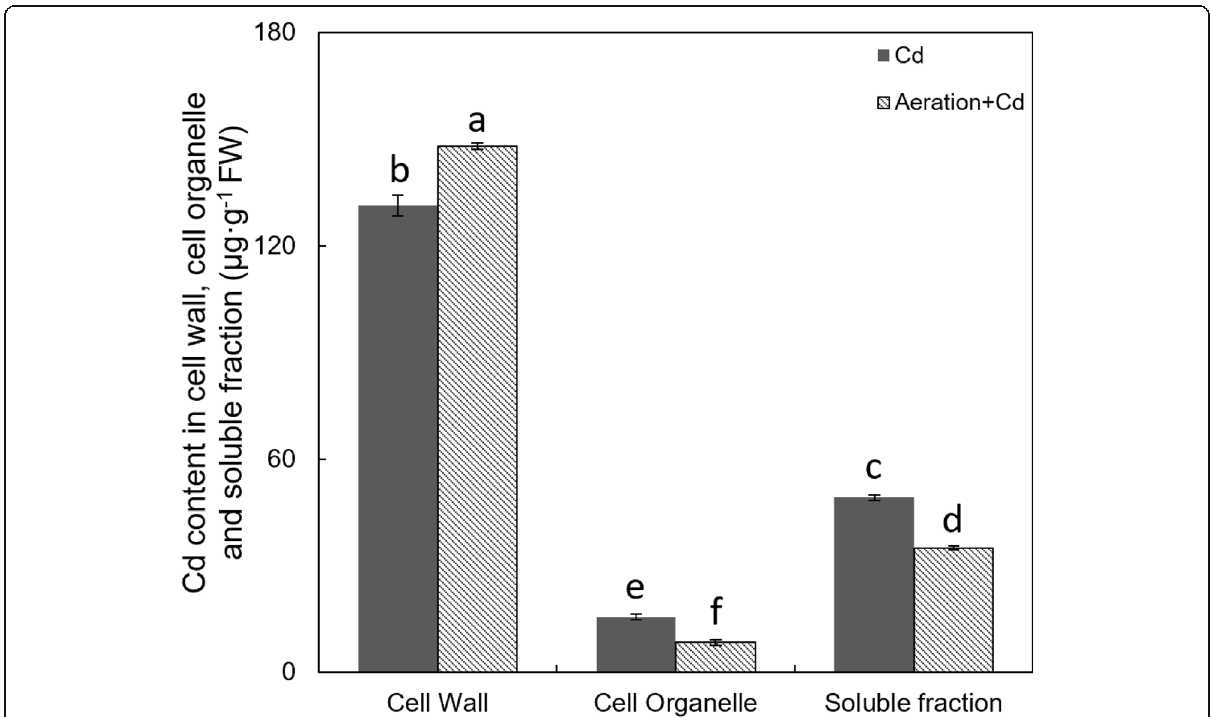
Fig. 6 Effects of aeration or/and 50 μ M CdCl 2 treatments on the location of Cd in rice root cells. Figure indicates Cd content in cell wall, cell organelle and soluble fraction. The 3-week-old rice seedlings under hydroponic culture were aerated with air pump (30 min per hour) in the absence or presence of 50 μ M CdCl 2 for 14 d. The values are means ± SE ( n = 3). Different letters on bar indicate significant differences at P <